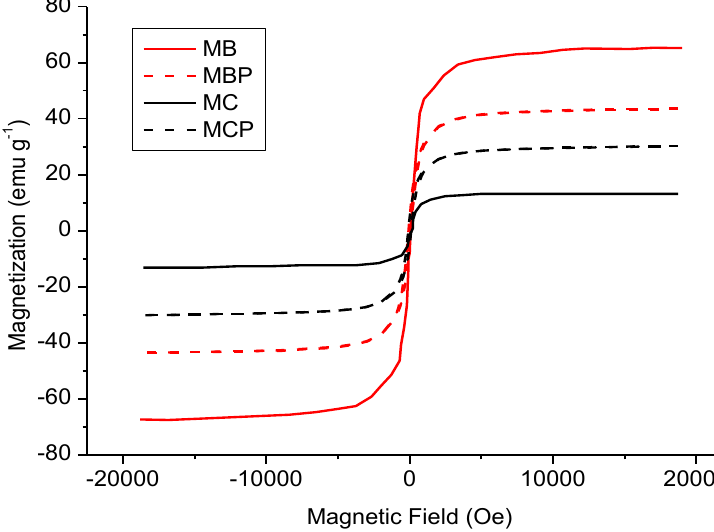
Figure 1. Magnetization curves related to the prepared samples. Legend: MB (BBS-stabilized magnetite), full red line, MBP (BBS-stabilized magnetite after pyrolysis at 550 °C) broken red line, MC (chitosan-stabilized magnetite), full black line, MCP (chitosan-stabilized magnetite after pyrolysis at 550 °C), broken black line.